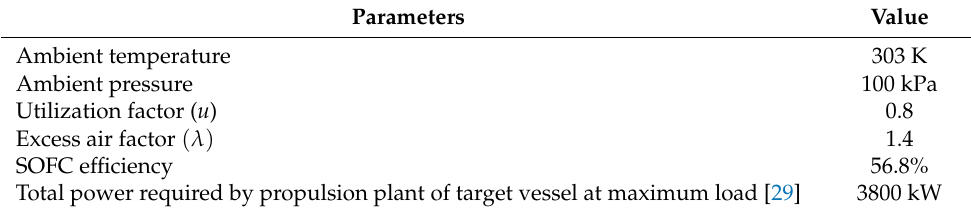
Table 2. Selected operating point.